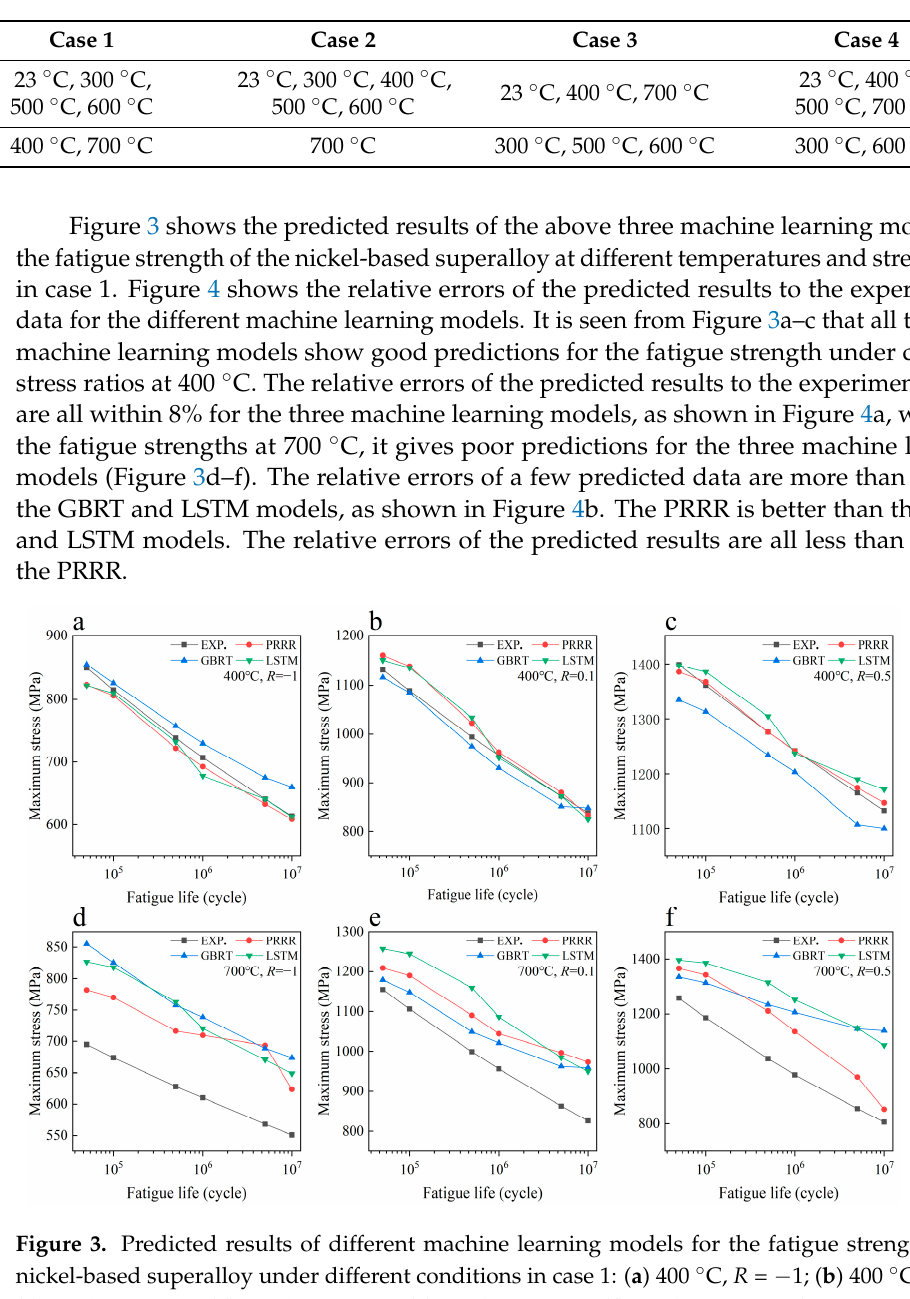
Figure 4. Relative errors of the predicted results to the experimental data for the different machine learning models in Figure 3: ( a ) 400 °C; ( b ) 700 °C. The range of relative errors is the same between the same numbers on the horizontal axis. Figure 5 shows the predicted results of different machine learning models for the fatigue strength of the nickel ‐ based superalloy in case 2. Compared with the results in Figure 3, the fatigue strength data at 400 °C are added in the training set for the predicted results in Figure 5. Figure 6 shows the relative errors of the predicted values to the exper ‐ imental data for the different machine learning models in Figure 5. A comparison of the relative errors of the predicted results by the different training sets in Figures 4b with Figure 6 shows that the predictive ability is not improved for all three machine learning models by increasing the normal data in the training set. There is still a large deviation between the predicted values and the experimental ones. The results in Figures 3–6 indi ‐ cate that the predicted results of the machine learning models depend strongly on the feature of the data in the training set. If the data in the training set cannot provide enough information for the data in the testing set (e.g., the anomalous data), it is hard to give reasonable or accurate predictions.